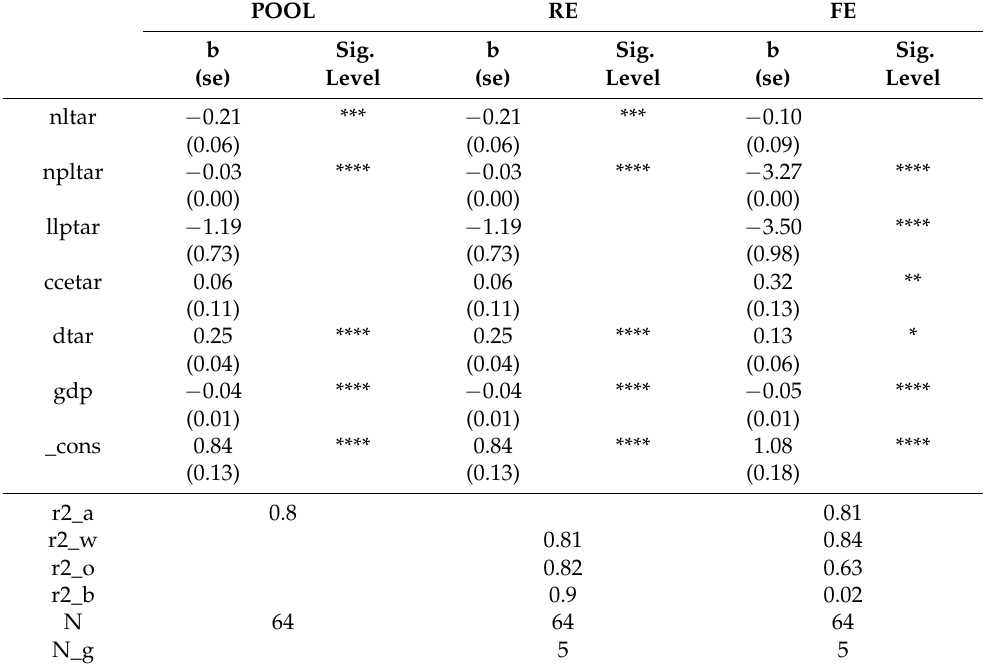
Table 4. Regression results for